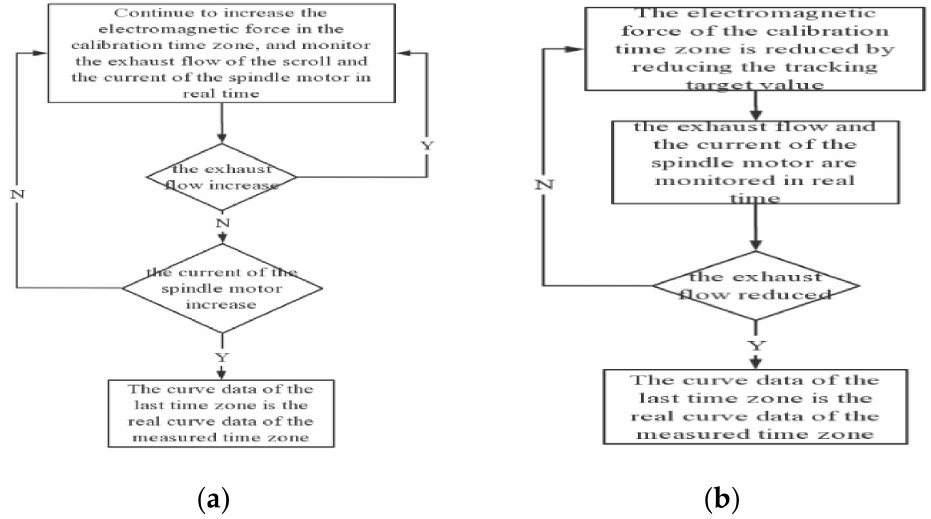
Figure 8. Segmented tracking process diagram: ( a ) flow chart of increasing electromagnetic force; ( b ) flow chart of reducing electromagnetic